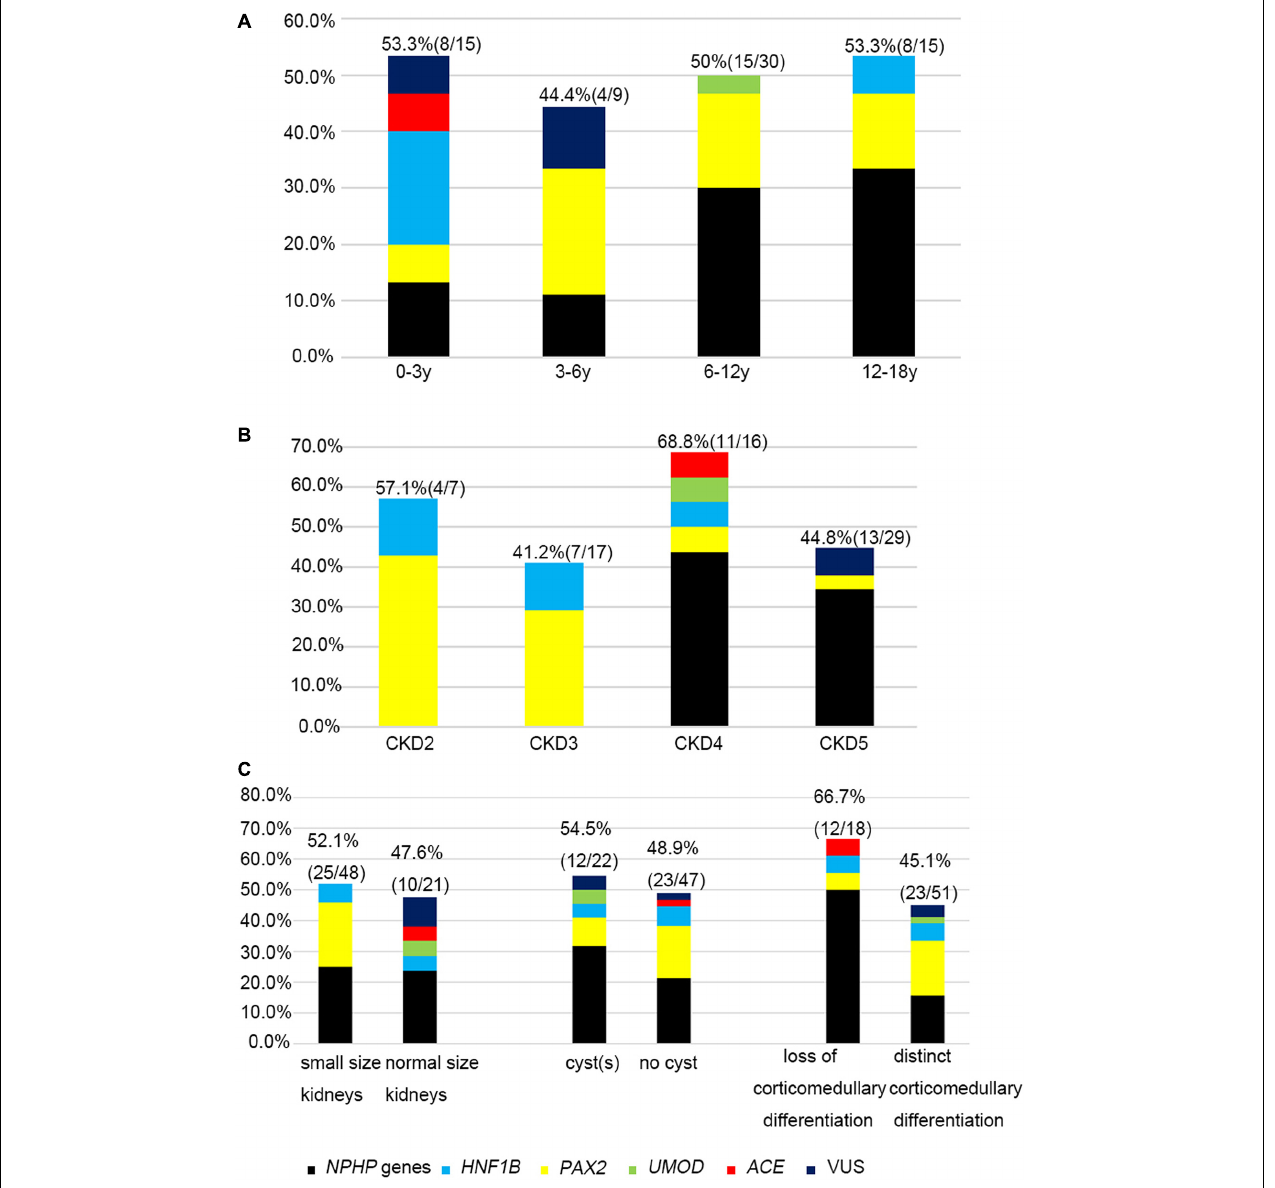
FIGURE 3 | The relationship between causative genes and clinical features. Histograms indicate fractions (in percentage) of patients with disease gene detected per group. (A) Genetic diagnosis and the age at onset for non-glomerular CKD. (B) Genetic diagnosis and CKD stages. (C) Genetic diagnosis and renal ultrasound